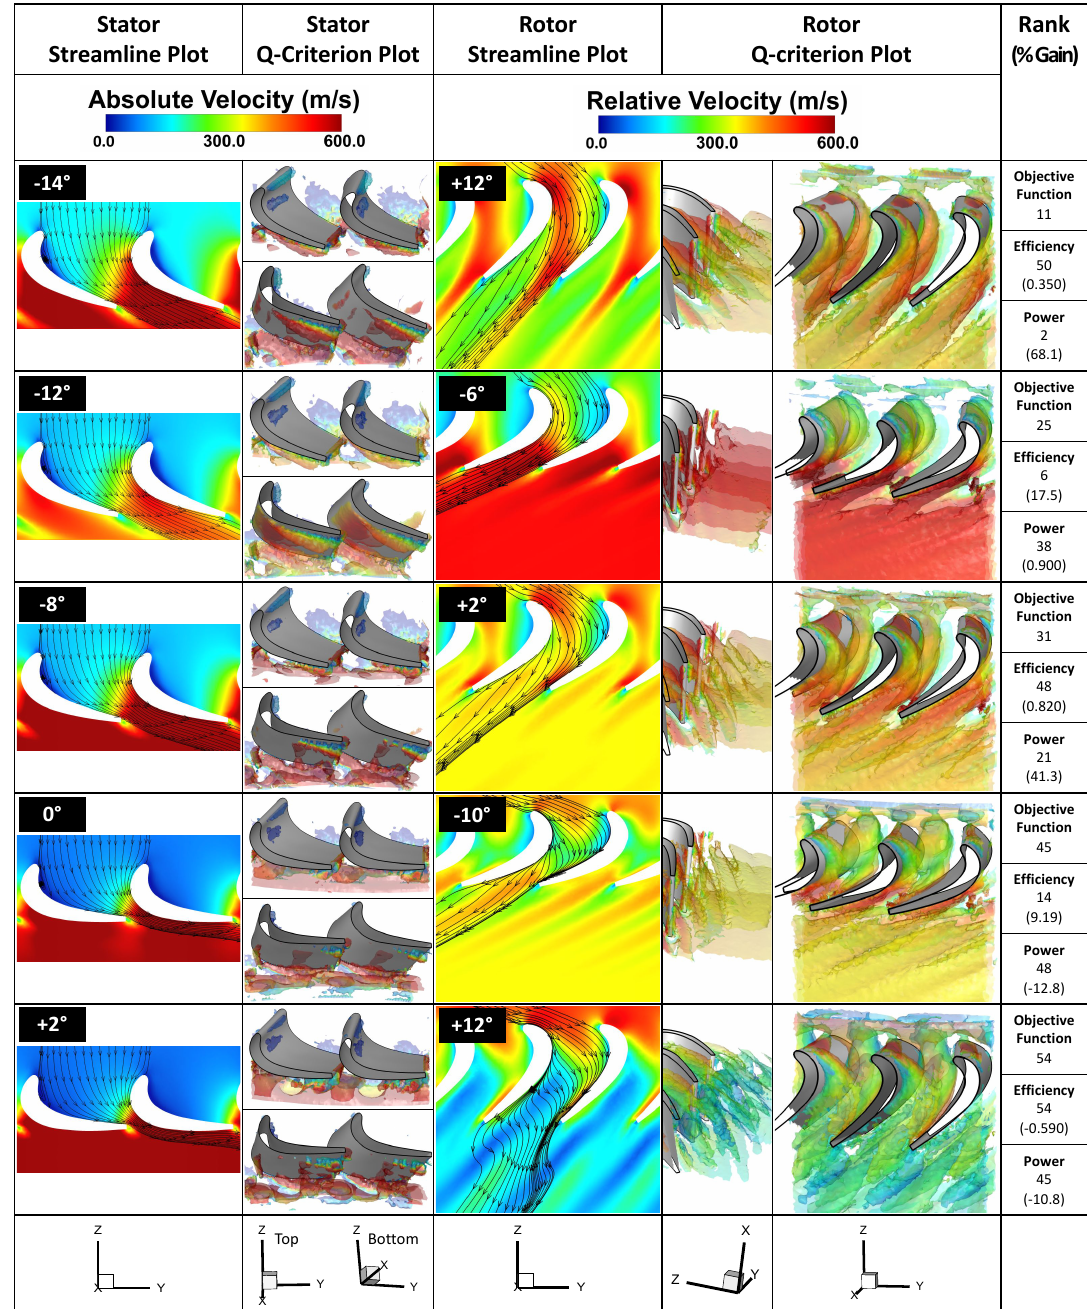
Figure 10. Flow field comparison using streamline and Q -criterion plots between five different cases taken from the design space. The stator plots use absolute velocity while the rotor plots use relative